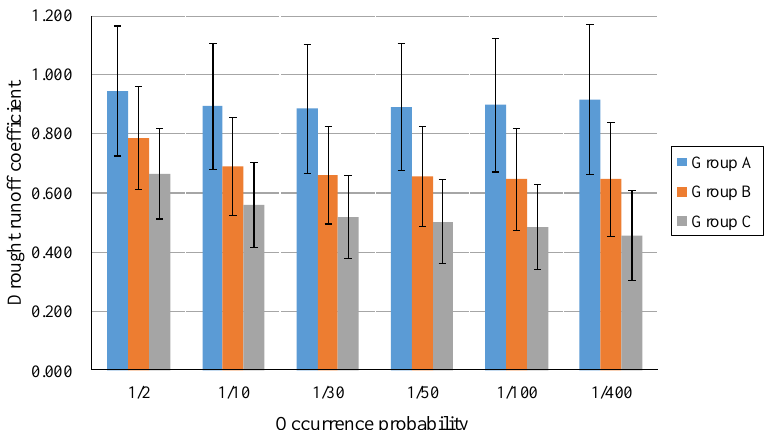
Figure 3. Characteristics of the average value of drought runoff coefficient for each occurrence probability in three groups.